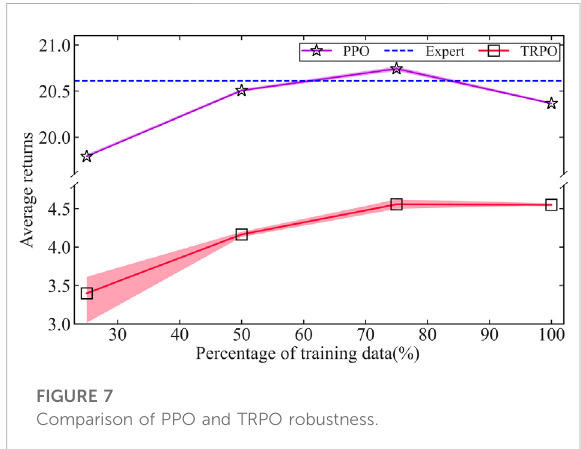
FIGURE 7 Comparison of PPO and TRPO